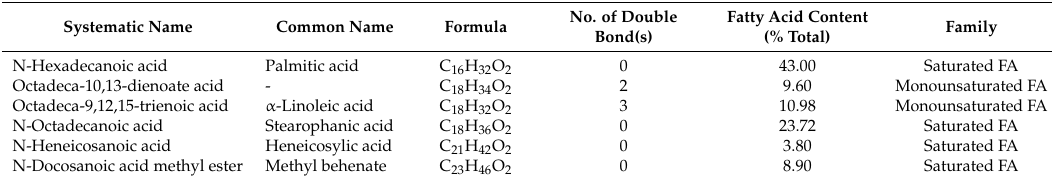
Table 4. Fatty acid (FA) composition of Dunaliella salina MCCS AB105